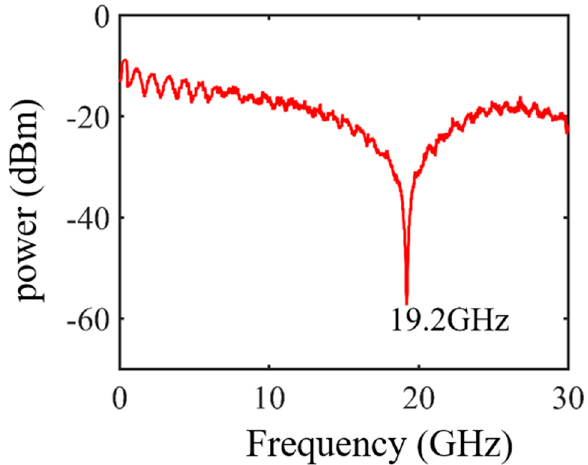
Figure 4. Experimental result of the power-fading effect after 10 km SMF transmission with double sideband modulation.